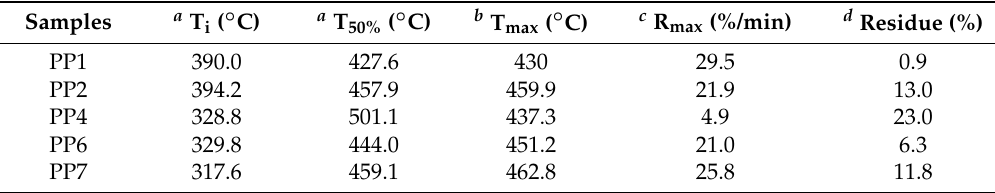
Table 3. TGA and DTG data of PP and PP composites under N 2 .